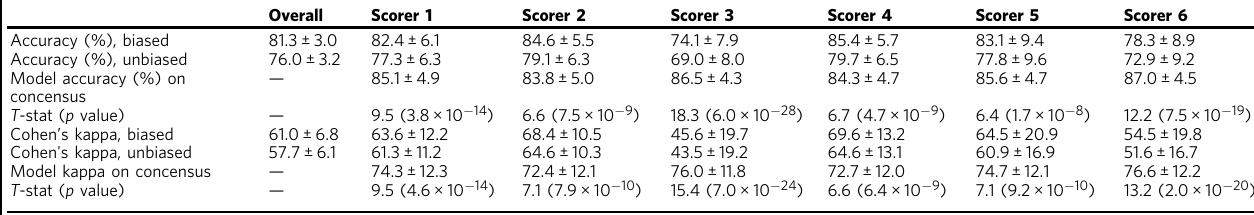
Table 1 Individual and overall scorer performance, expressed as accuracy and Cohen ’ s kappa